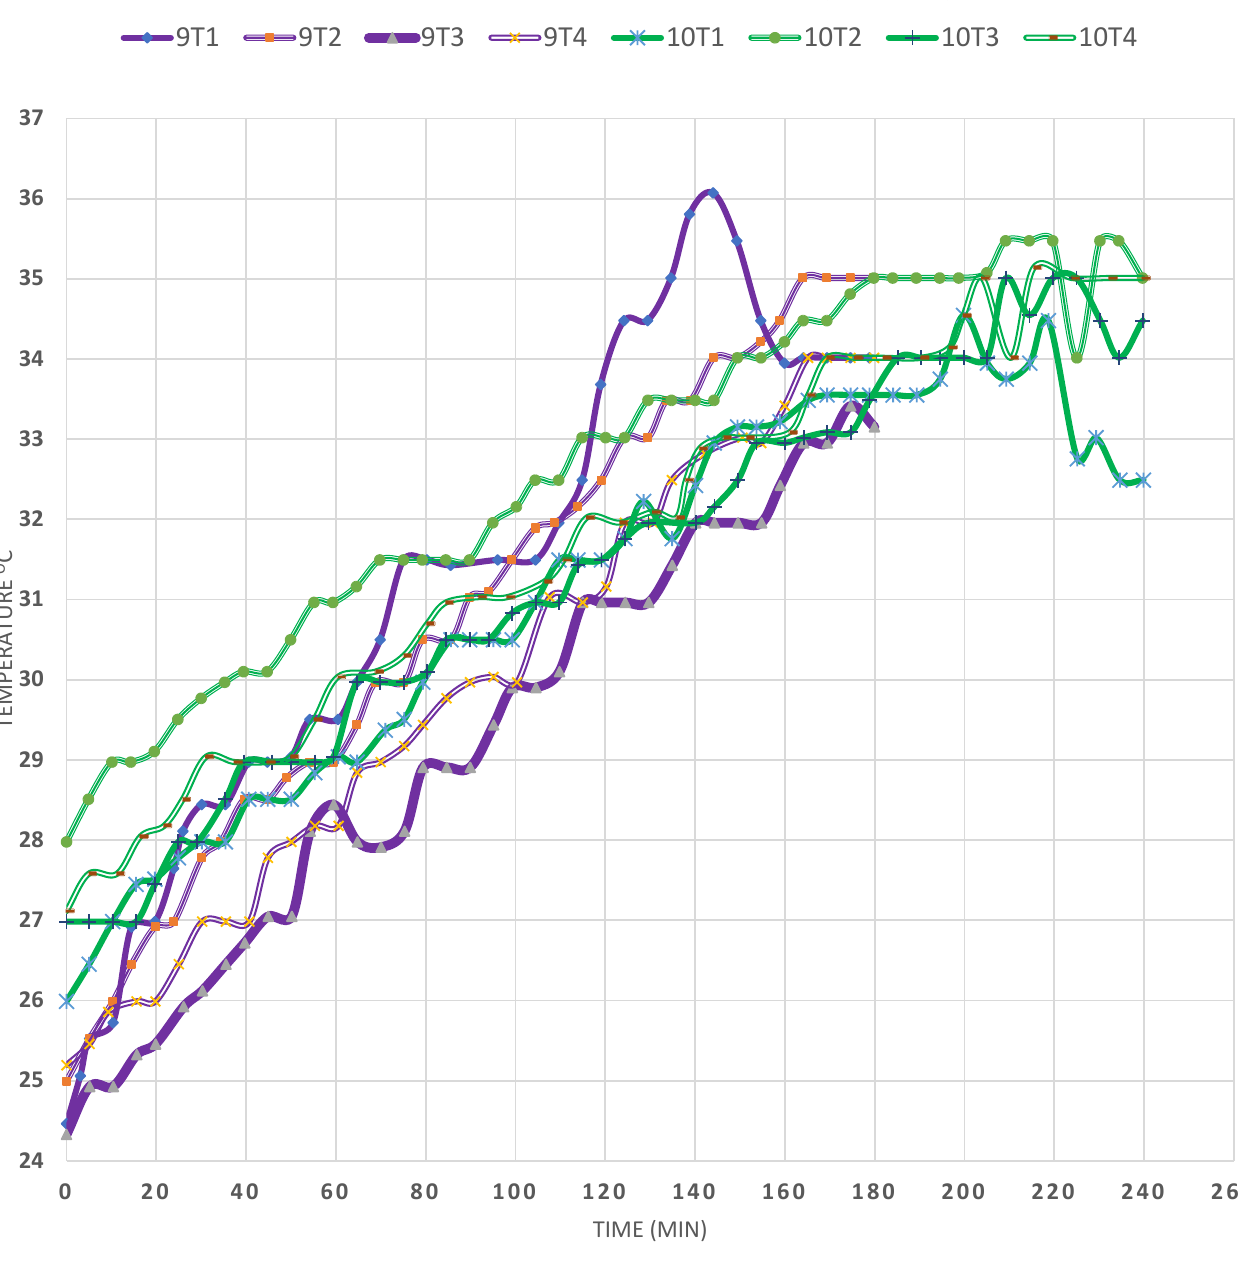
Figure 7. Effect of reproducibility (EXPs 9 and 10).